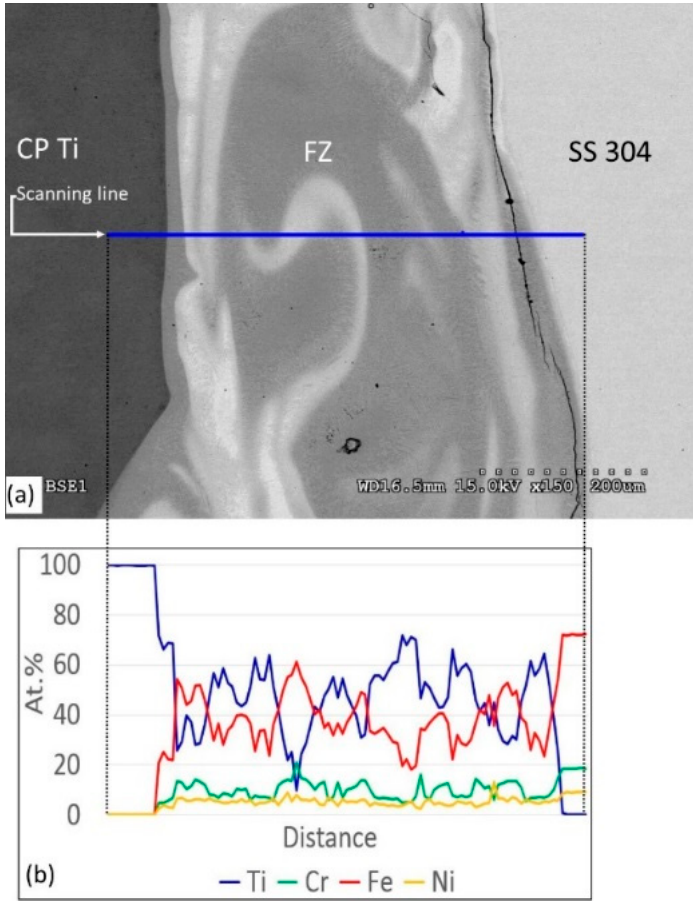
Figure 5. ( a ) Backscattered electron image and ( b ) chemical composition (at.%) of the area along the scanned line of LBW weld